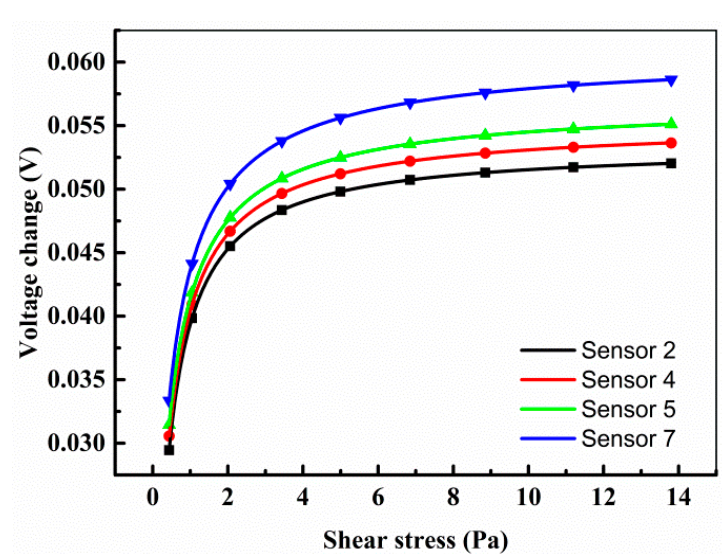
Figure 6. Pressure difference with various velocities.